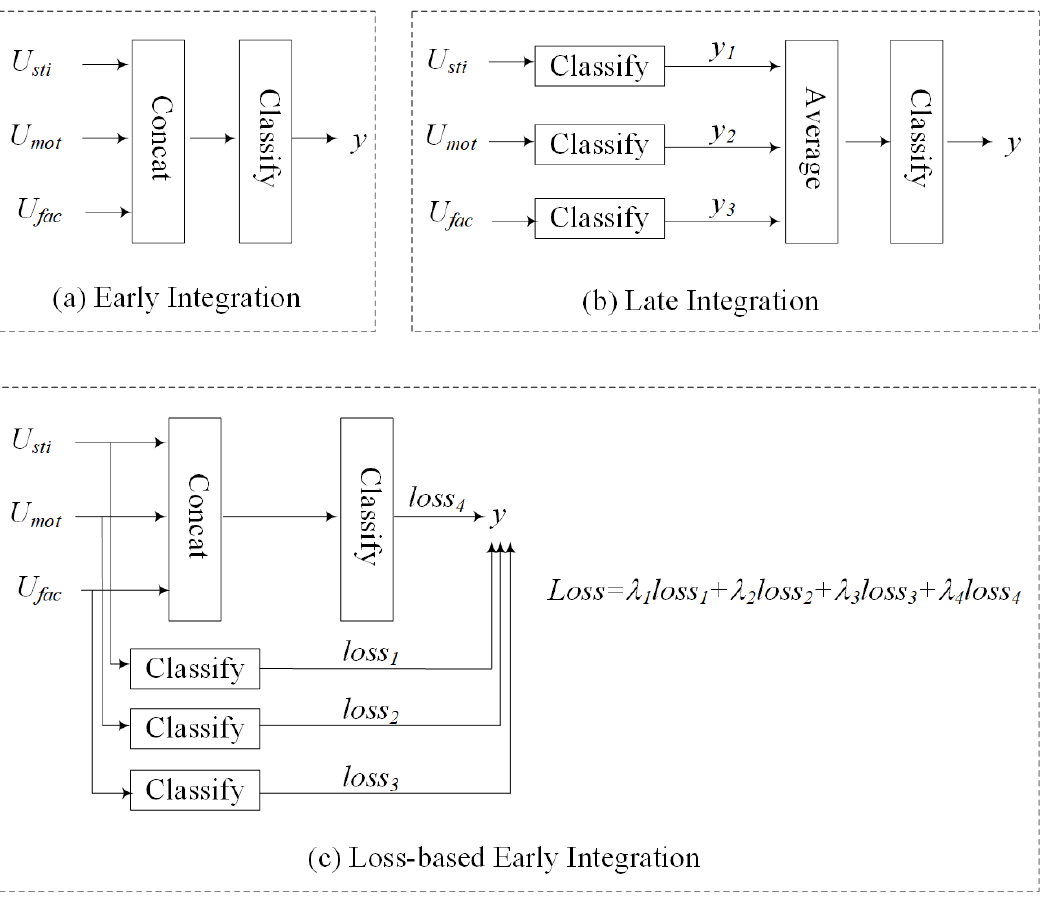
Figure 6. Three other integration methods: Early integration, loss-based early integration, and later integration. In the loss-based early integration Loss = λ 1 loss 1 + λ 2 loss 2 + λ 3 loss 3 + λ 4 loss 4 , λ 1 , λ 2 , λ 3 , and λ 4 are set as 0.2, 0,2, 0,2, and 0,4, respectively.